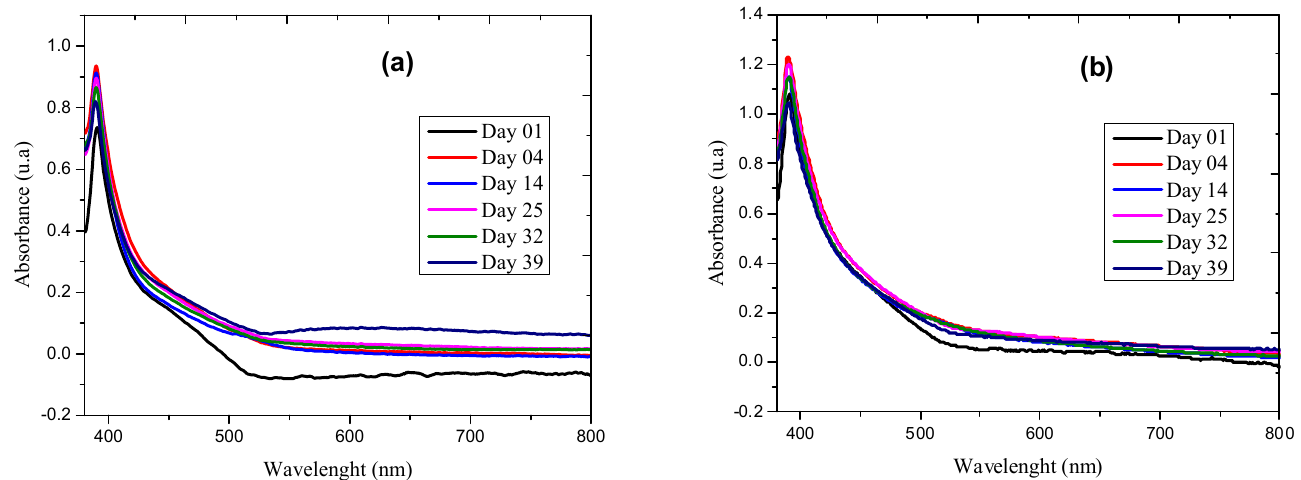
Figure 3. Evaluation of the stability of FeO NP by UV-vis spectrophotometry: ( a ) with extract in alcoholic extract 96% and ( b ) with extract in absolute ethanolic extract.